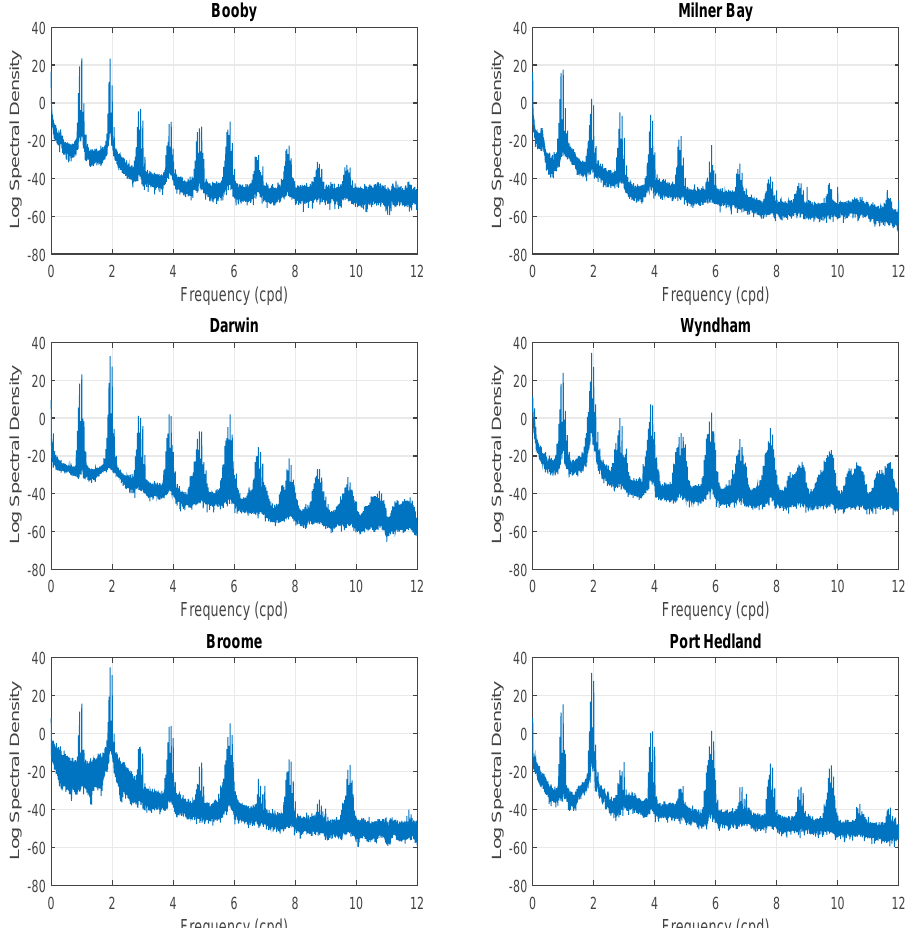
Figure 9. PSD of observed SLA from tide gauges located on the north and northwest coast of Australia. Scales are identical in all graphs.